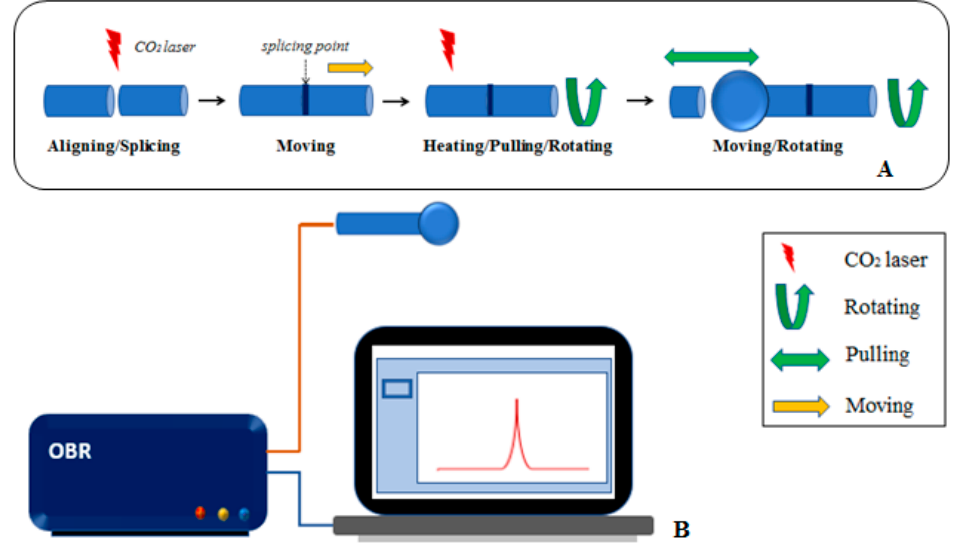
Figure 2. Experimental set-up used in this study; ( A ) fabrication of ball resonator sensor on a CO 2 splicing machine; ( B ) interrogation of the sensor with optical backscatter reflectometer. The interrogator is an optical backscatter reflectometer (OBR; OBR4600, Luna Inc., Roanoke, VA, USA), with the following parameters: scan range 1525–1610.6 nm; gain 0 dB; resolution bandwidth 0.257 GHz.